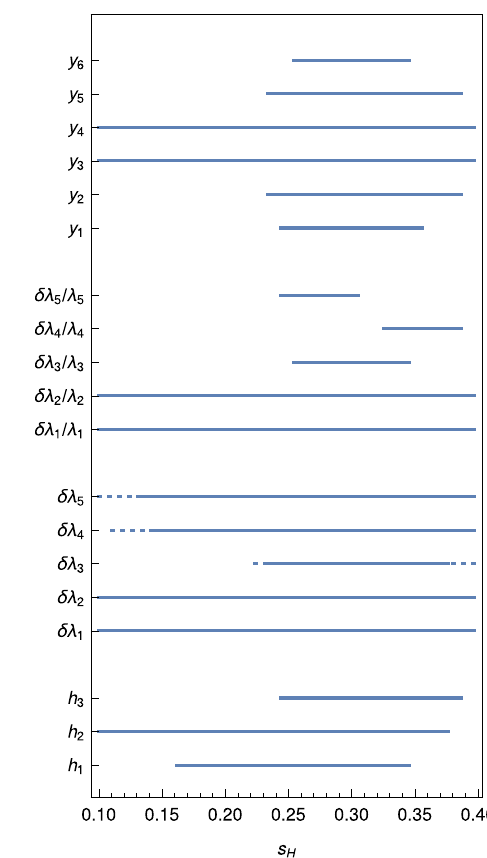
(iii) | δλ x /λ x | < 1., (iv) y i are the absolute values of different eigenval- ues of the scattering matrix when using λ N + δλ Nx as ) − ( m 2 ) | > Tree 1L h i h i